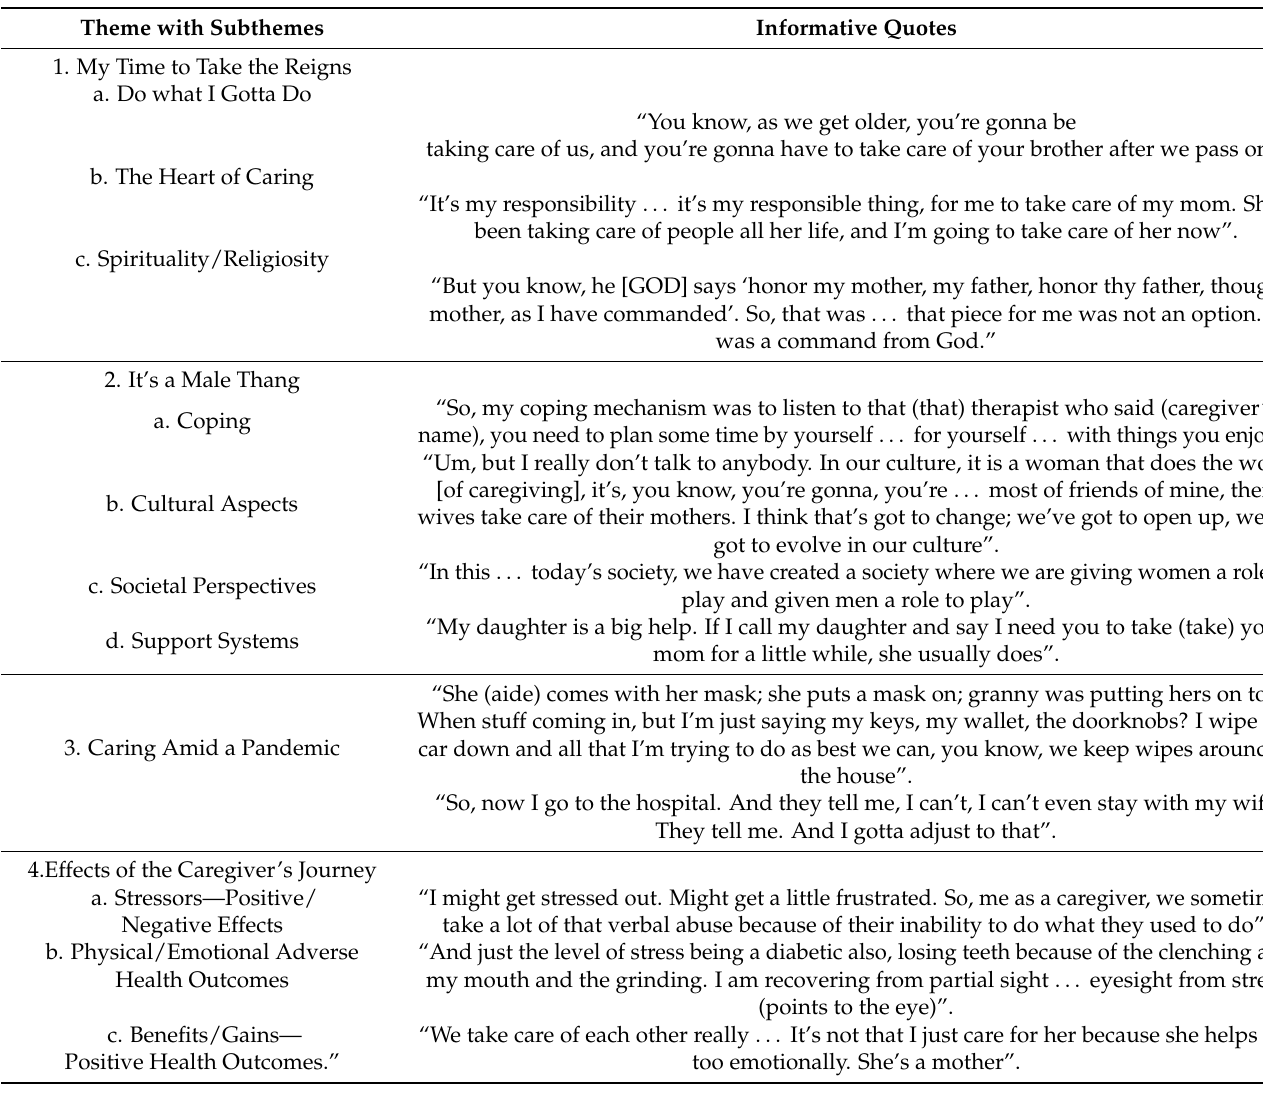
Table 3. Major themes and caregiver